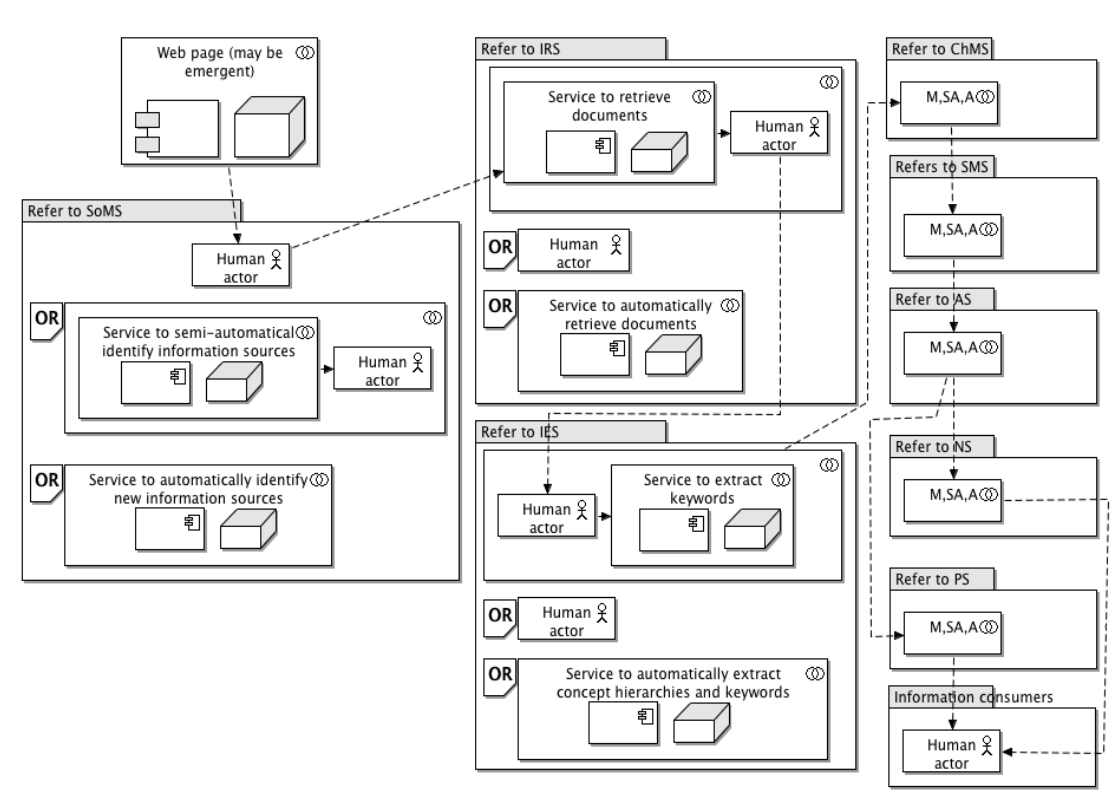
Figure 11. Variations in information logistics